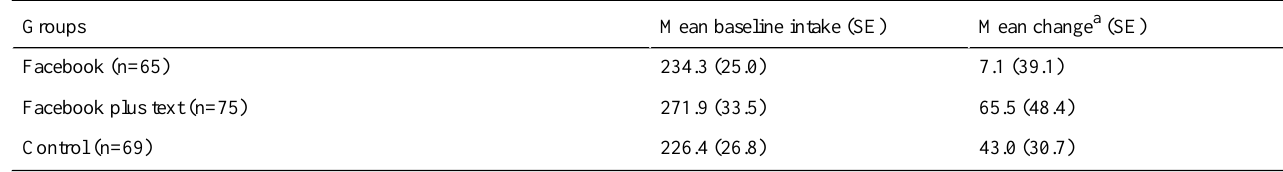
Table 4. Change in calcium intake per day in mg (excluding milk) from baseline to the end of the intervention using logistic regression for all participants (n=209, using imputed dataset); P